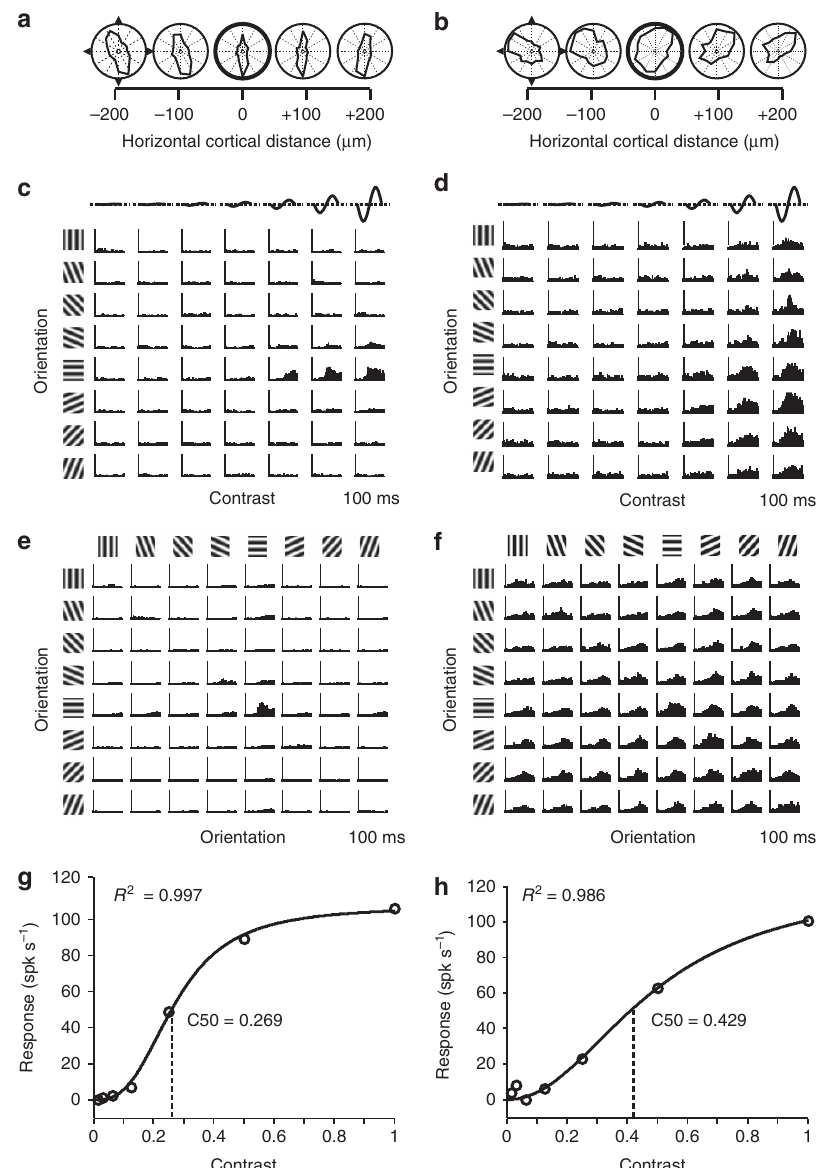
Figure 1 | Responses from iso-orientation and pinwheel sites. Recordings from two representative sites using a 32 channel probe (100 m m between recording sites) inserted tangentially into primary visual cortex. Left column: iso-orientation site. Right column: pinwheel site. ( a , b ) Polar plots showing the orientation preference for each of the two sites and their nearest two sites on either side, separated by 100 m m. ( c ) Peristimulus time histogram matrix for gratings oriented at 0 (cid:2) , 22.5 (cid:2) , 45 (cid:2) , 67.5 (cid:2) , 90 (cid:2) , 112.5 (cid:2) , 135 (cid:2) and 157.5 (cid:2) (left margin) at contrasts ¼ 1/64, 1/32, 1/16, 1/8, 1/4, 1/2 and 1.0. (top margin). This site responds primarily to horizontal orientations. ( d ) Peristimulus time histogram matrix for the same gratings for a broadly tuned site. ( e , f ) Peristimulus time histogram matrix of responses to plaids composed of gratings at 50% contrast, oriented as in the top and left margins. ( g , h ) Responses to increasing contrast of single gratings of preferred orientation, fit with a Naka–Rushton function. Lower semi-saturation constant (C50) corresponds to greater response